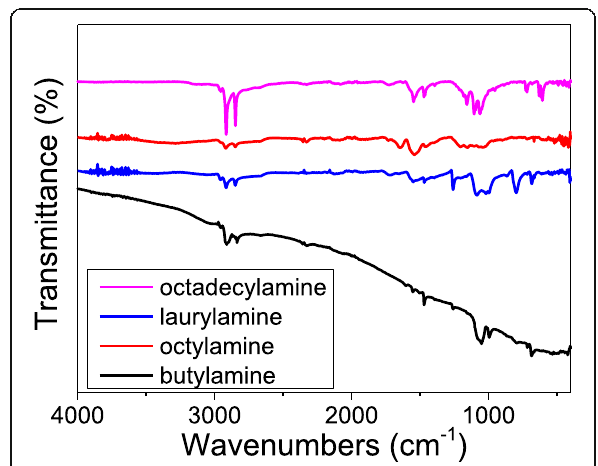
Fig. 4 The ATR-FTIR spectra of the SA-GO which is prepared by the reactions of butylamine, octylamine, laurylamine, octadecylamine, and the sulfur-doped graphene oxide (the oxidation time of the graphene oxide is 24